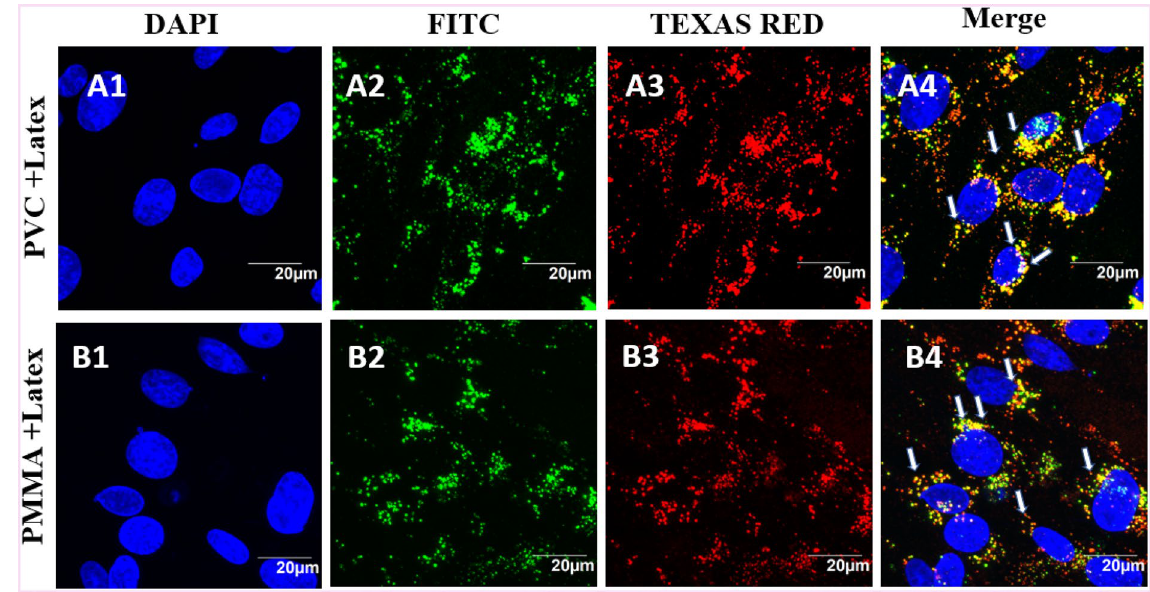
Figure 6. BHK-21 cells exposed to PVC ( A1 – A4 ) and PMMA ( B1 – B4 ) NPs at a concentration of 200 µg/mL for 24 h and latex beads (80 µg/mL). The images represent nucleus stained with Hoechst dye and cells exposed to PVC or PMMA NPs (green emitting, A2 , B2 ) and red fluorescent latex beads ( A3 , B3 ). The blue, green and red fluorescent images are overlaid to show the localization of PVC and PMMA NPs and latex beads inside the cell, indicating that PVC and PMMA NPs are entering the cell by